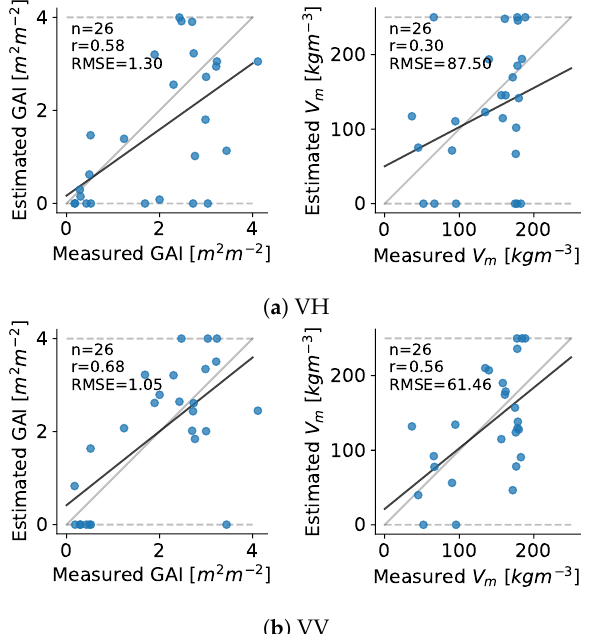
Figure 12. Results from the LOOCV for the retrieval of either maize GAI or volumetric surface soil moisture, V m , using the algebraic inversion of the WCM with C-band data in ( a ) cross-polarization, VH; ( b ) vertical co-polarization, VV. Table 4. Results from the leave-one-out cross-validation (LOOCV) for the retrieval of either GAI or volumetric surface soil moisture, V m , in maize fields from ( a ) L- and ( b ) C-band backscattering measurements ( n = 26) with the algebraic inversion of the